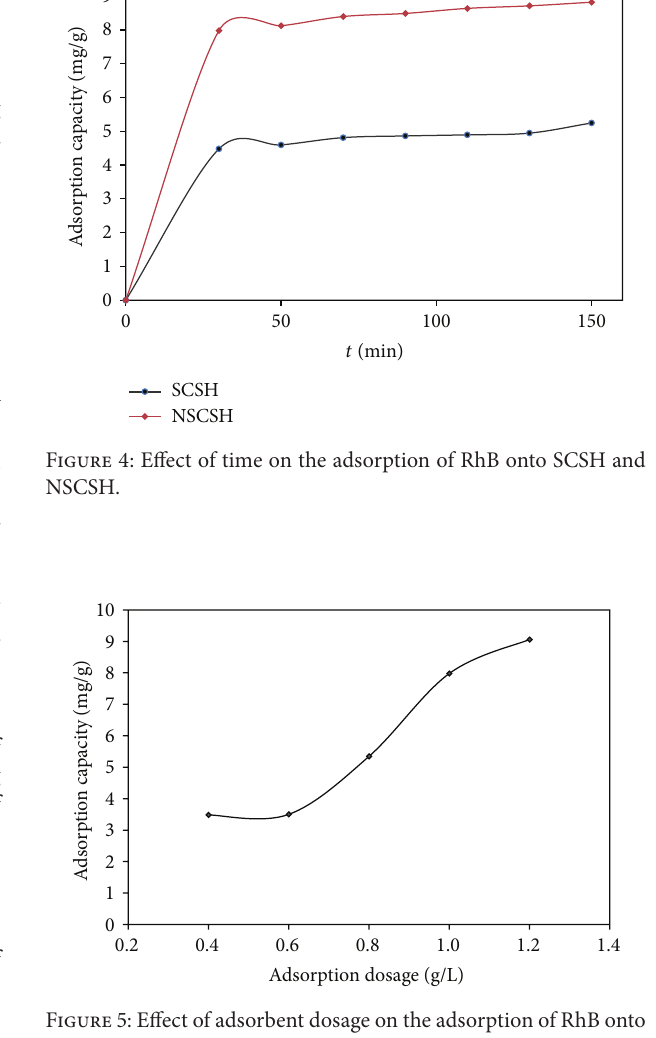
agglomerates or compacts of approximately uniform spheres